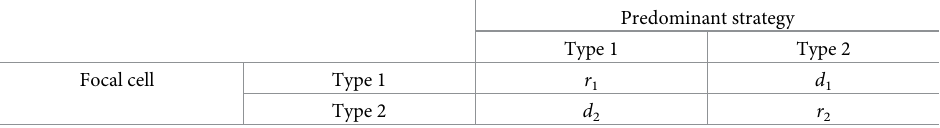
Table 1. An evolutionary coordination game with two strategies. The payoffs satisfy r 1 � r 2 � d 1 , d 2 . Special cases: Pure coordination (